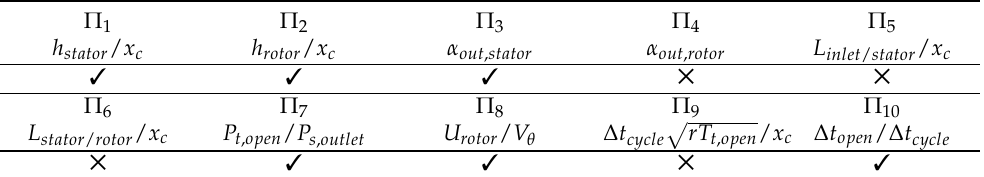
Table 3. Factors’ influence on the output. (cid:51) is associated with an influential factor, while (cid:53) is related to a noninfluential